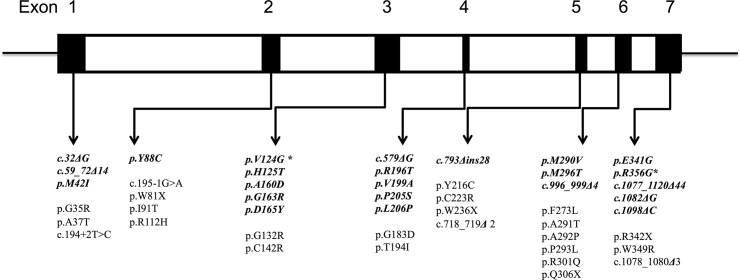
Schematic of the α-galactosidase A gene indicating the relative position of the seven exons and showing the 47 mutations, including 23 novel mutations (Bold Italic).Abbreviations used: P205S (proline to serine substitution at codon 205); ins, insertion; Δ, deletion. Numbers for deletions or insertions refer to the nucleotide position in the α-galactosidase A cDNA sequence. *novel mutation found in two presumably unrelated families.